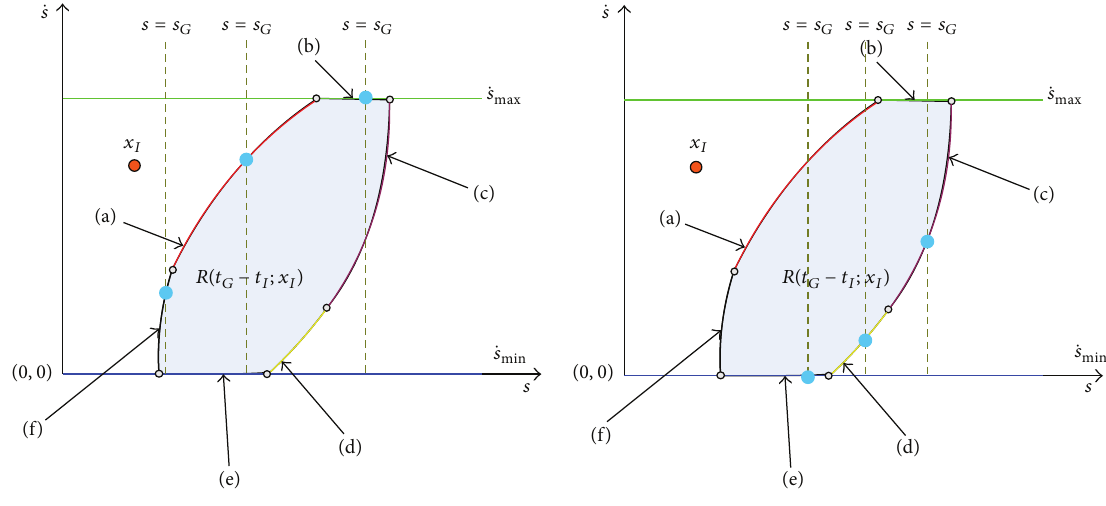
Figure 4: Reachable velocity sets from one initial